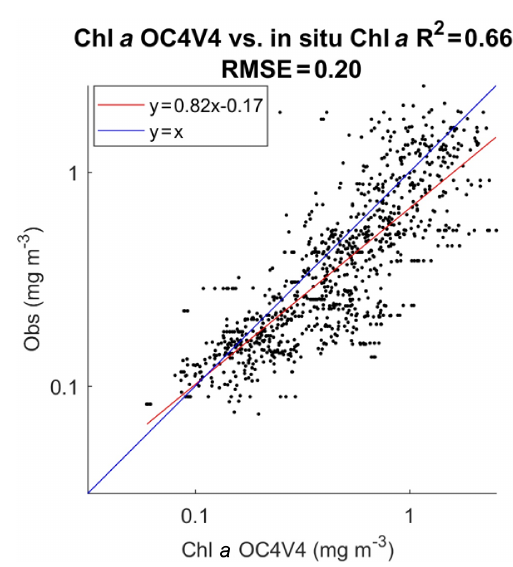
Figure 3. Dispersion diagram of DPIG chl a computed from the SeaWiFS observations using the OC4V4 algorithm versus in situ chl a . The coefficient of determination R 2 and the RMSE (root mean square error) were computed in milligrams per cubic meter (mgm − 3